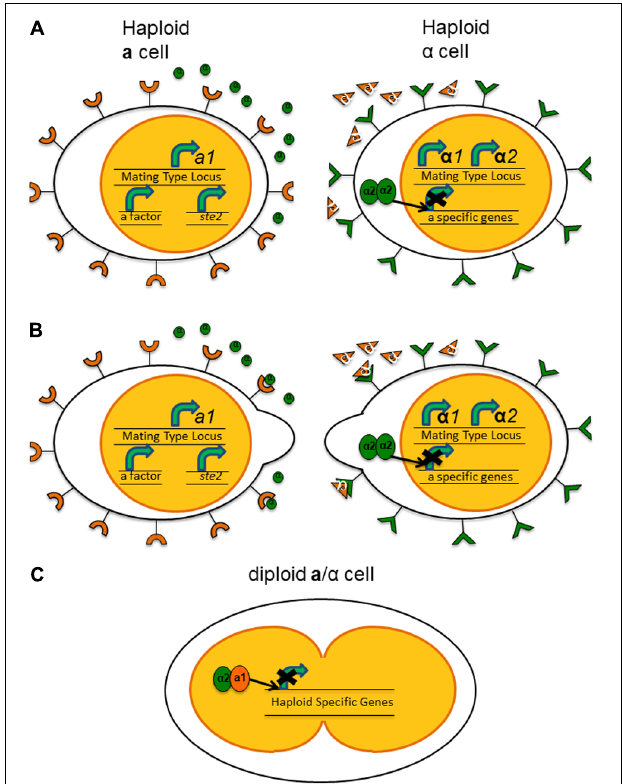
FIGURE 1 | Expression of haploid-specific genes in Saccharomyces cerevisiae leading to mating between haploid cells. (A) In the haploid a cells, a1 , the homeodomain protein, is expressed constitutively from the mating type locus. While the genes for the pheromone and pheromone receptor are not located within the mating-type loci, in the haploid a cell, the a-factor and Ste2, the receptor for α -factor, are both expressed constitutively as well. In the haploid α cells, α 1 and α 2 are expressed from the mating type locus. α 2 forms a homodimer to block transcription of a -specific genes. (B) The interaction of pheromone with its receptor on the cell of the opposite mating type results in the formation of a “shmoo” structure, a protrusion of the cytoplasm, toward each other. (C) Fusion of the cells and subsequently the nuclei. In the diploid a/ α cell, α 2 and a1 form a heterodimer to block expression of haploid-specific